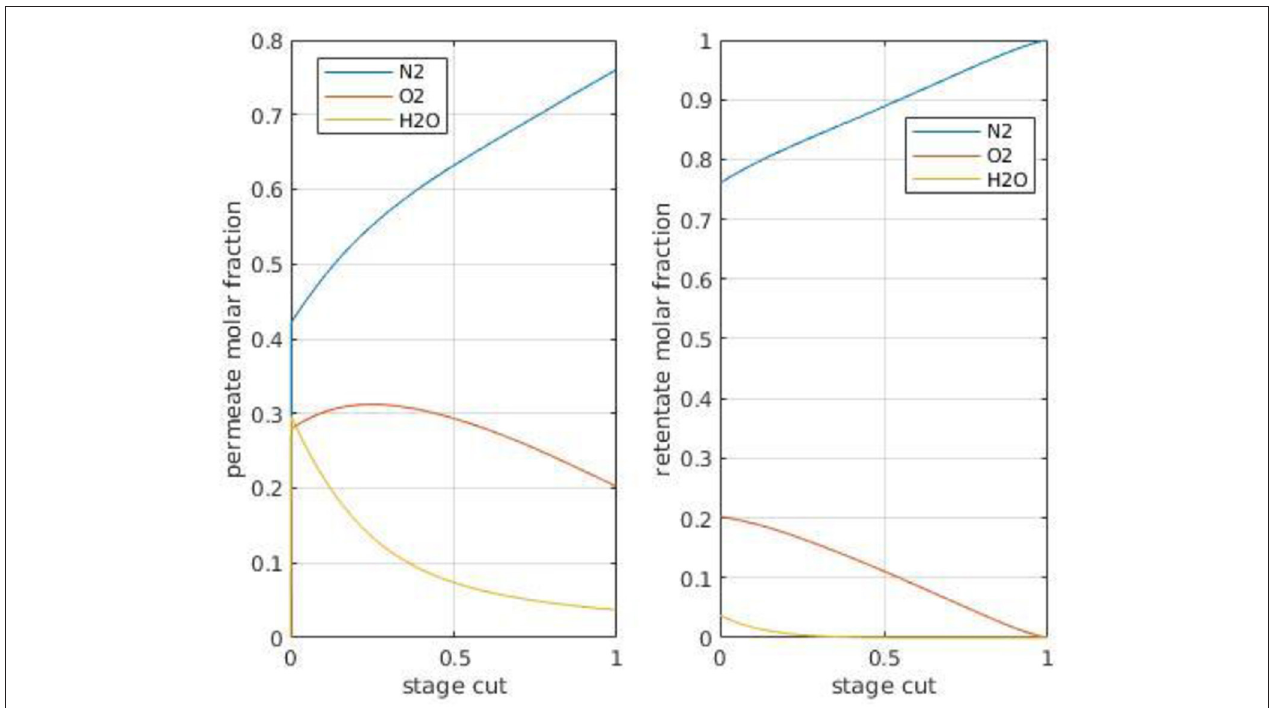
FIGURE 8 | Retentate (x out ) and permeate (y) compositions for different air compounds as a function of module stage cut with a Polyactive membrane (#2 in Table 2 ). Permeance in GPU: CO 2 : 1,100, N 2 : 28.5, O 2 : 77.8, H 2 O: 2,000 (Brinkmann et al., 2017). Pressure ratio ( ψ ) 0.01, cross plug flow conditions.